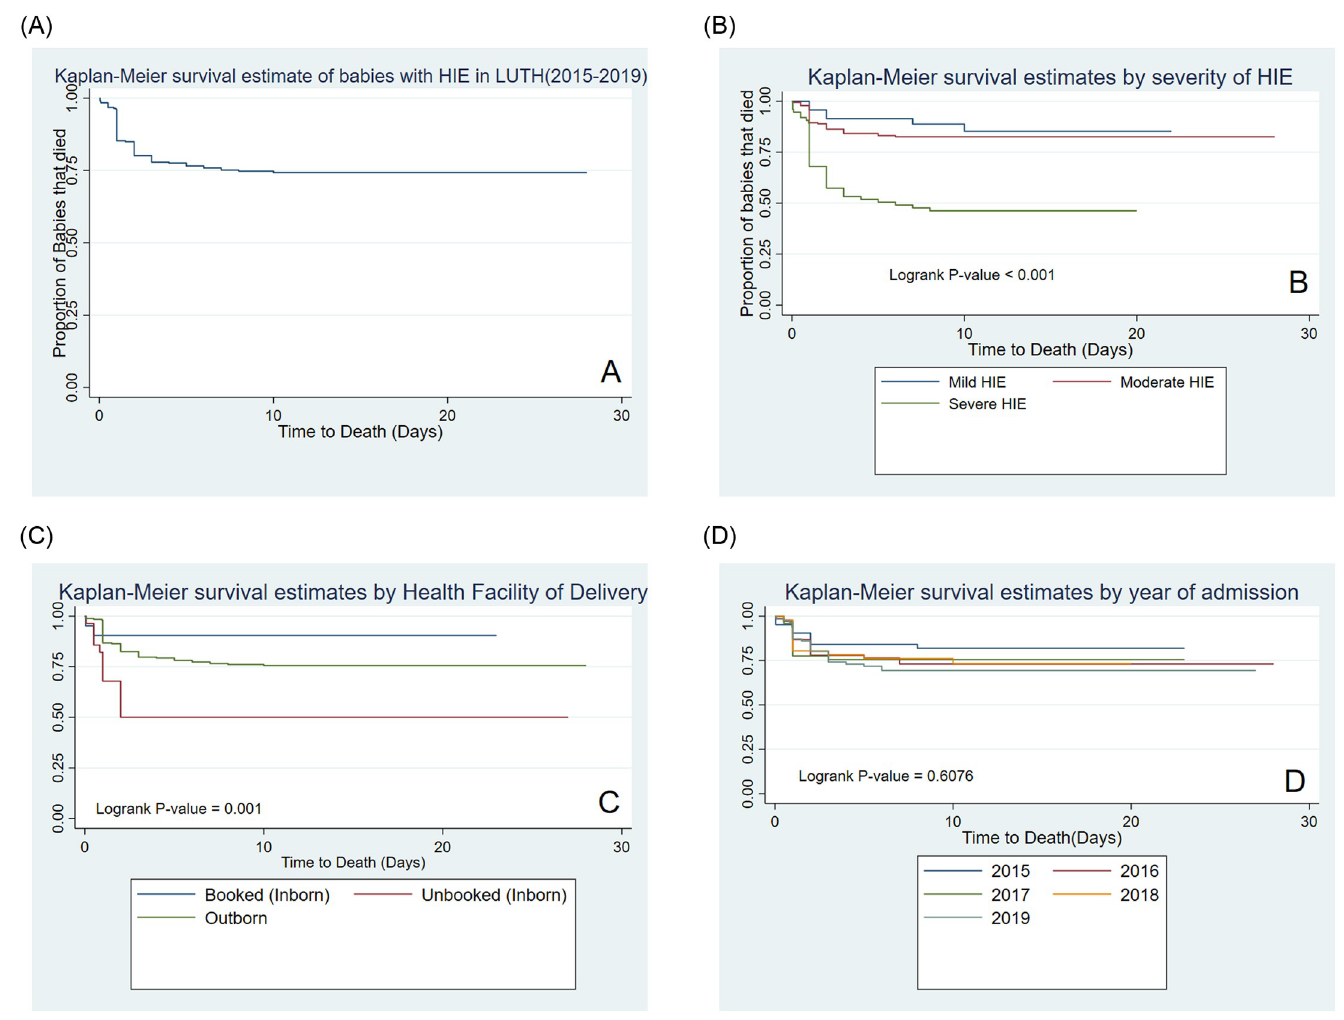
Fig 2. The Kaplan-Meier survival experience of the cohort (A), severity of HIE (B), by place of birth (C), and year of admission (D).